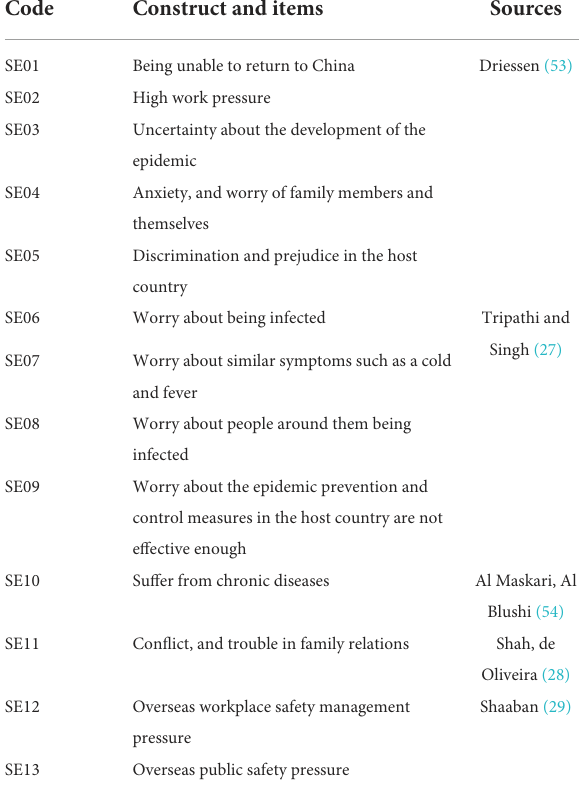
TABLE 2 The checklist of stress events related to